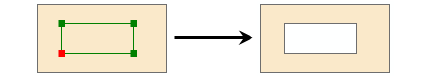
Figure 7. PLTS Create Hole tool result. Source: ArcGIS Desk- top 9.3 Web help